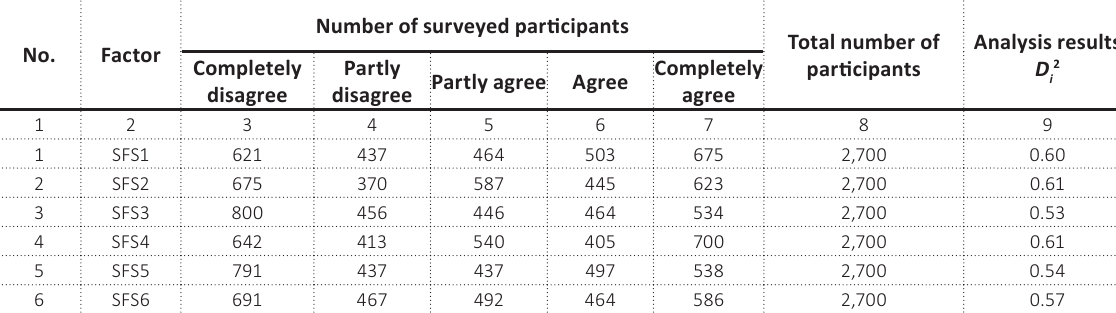
Table 4. Effectiveness of smart faculty staff (SFS) No.